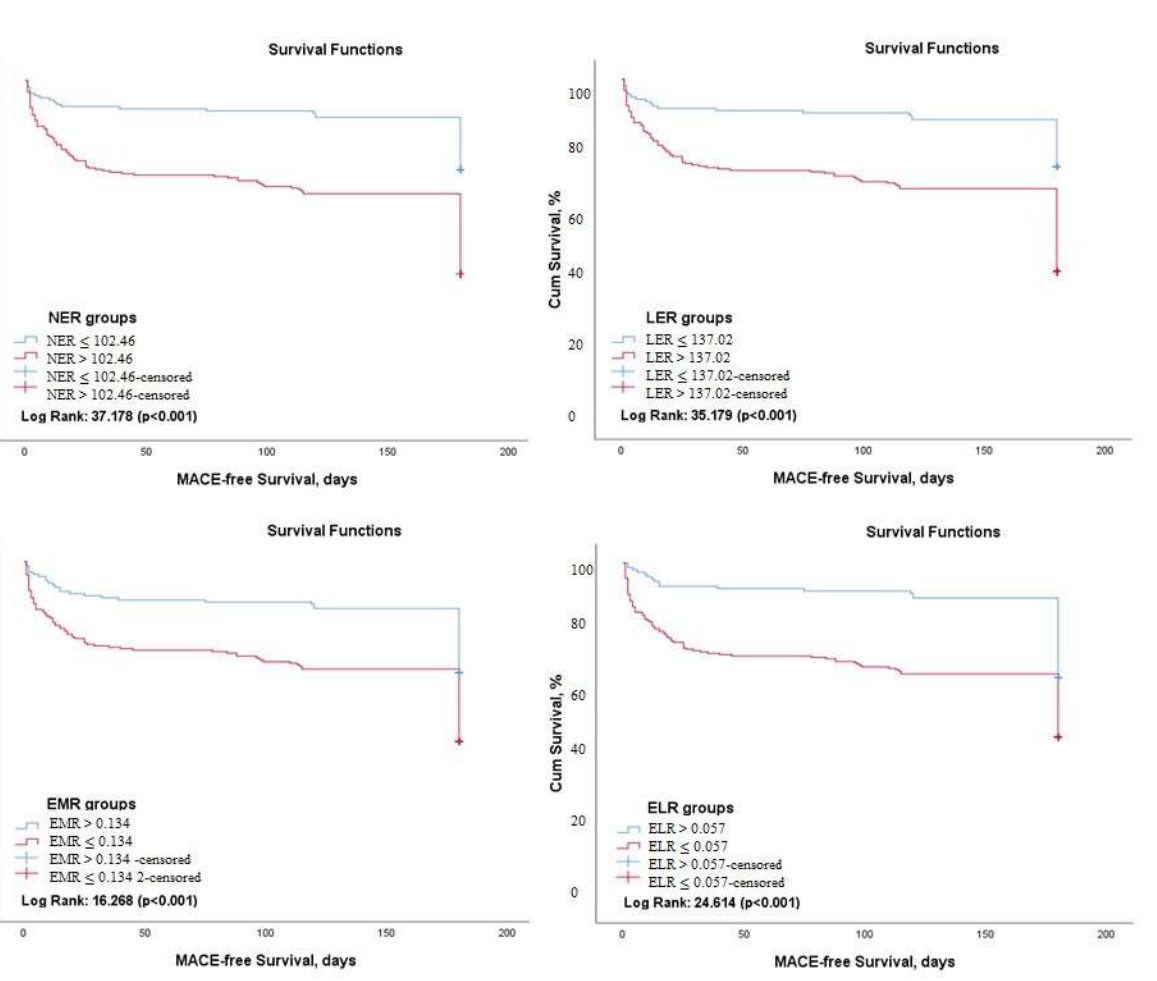
AUC: Area under the curve, NER: Neutrophil-to-Eosinophil ratio, LER: Leukocyte-to-Eosinophil Ratio, EMR: Eosinophil-to-Monocyte Ratio, ELR: Eosinophil-to-Lymphocyte ratio. Kaplan–Meier survival analysis demonstrated that 6-month MACE-free survival was significantly higher in patients with an NER value of ≤102.46 (Log rank: 37.17, p < 0.001), an LER of ≤137.02 (Log rank: 35.18, p < 0.001), an absolute eosinophil count of ≥0.045 (Log rank: 24.88, p < 0.001), an EMR of ≥0.134 (Log rank: 16,26 p < 0.001) and those with an ELR